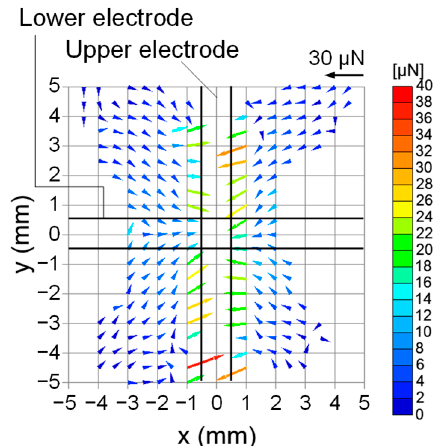
Figure 6. Experimentally obtained electrostatic forces experienced by the glass sphere.